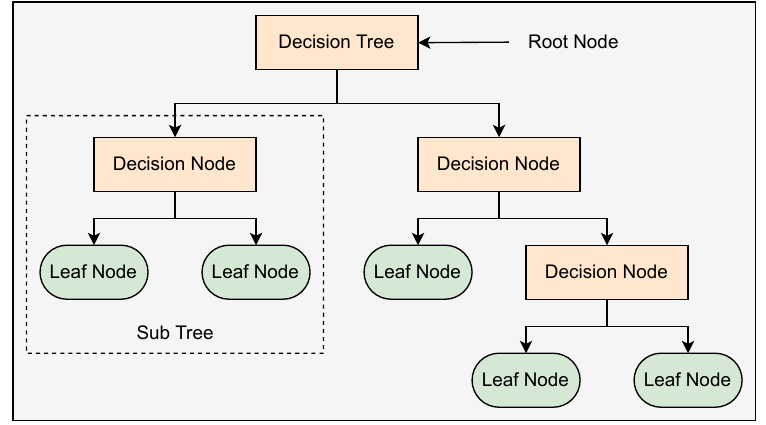
Figure 4. Structure of Decision